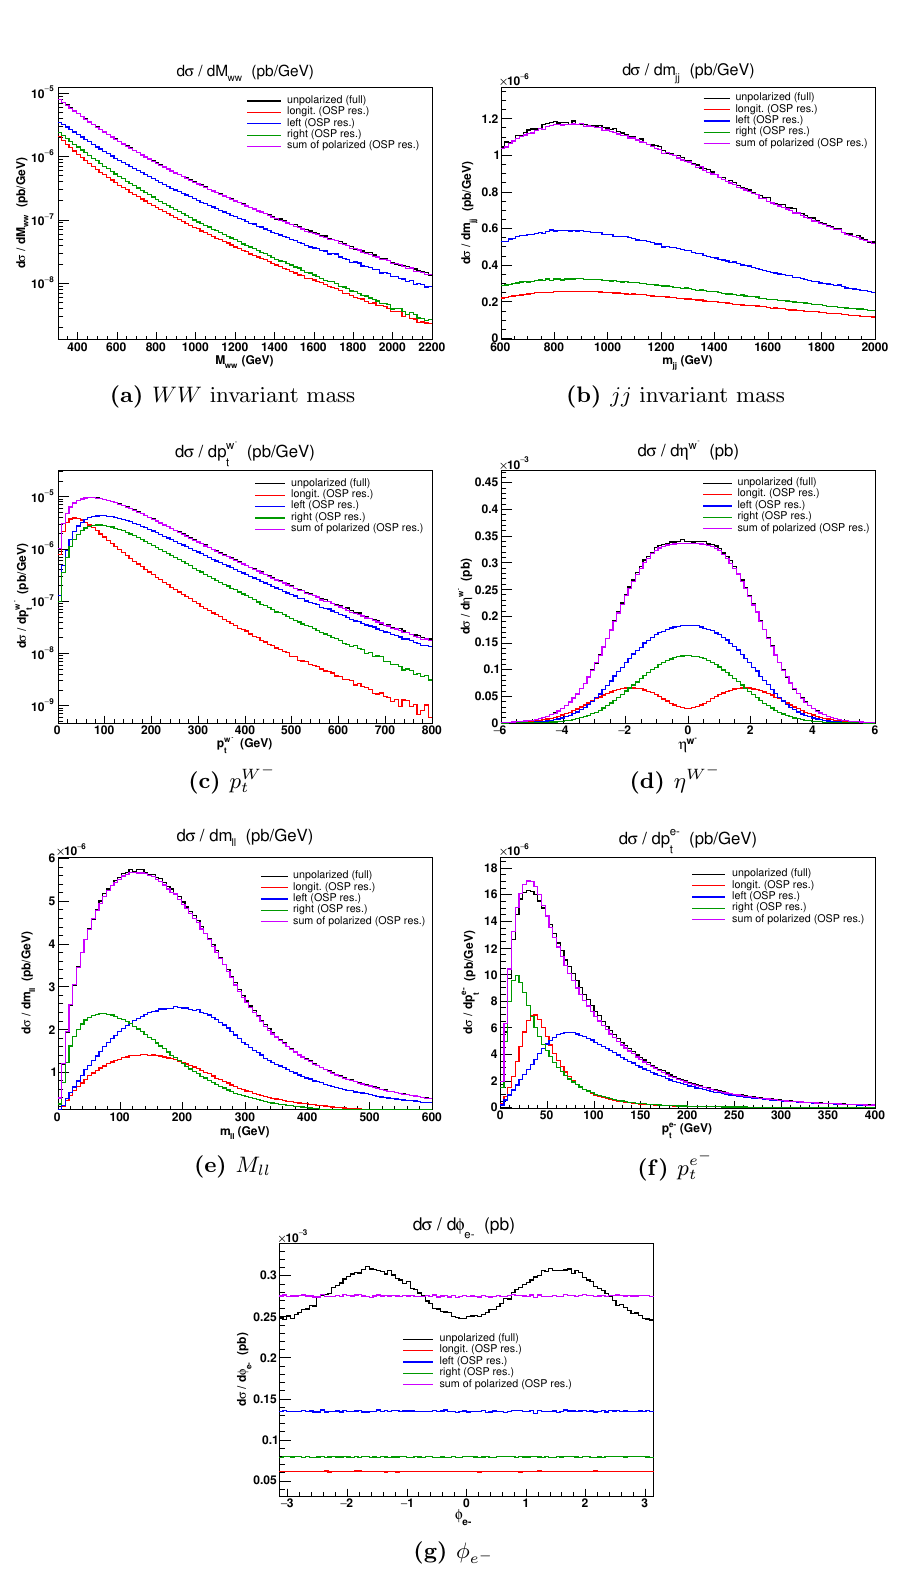
Figure 3. Di(cid:11)erential cross sections for pp ! jje (cid:0) (cid:22) (cid:23) e (cid:22) + (cid:23) (cid:22) at the LHC@13 TeV. Comparison between unpolarized generations based on the full amplitude and the incoherent sum of the polarized gener- ations with OSP, which take into account only the resonant diagrams. No cut on leptonic variables. { 11